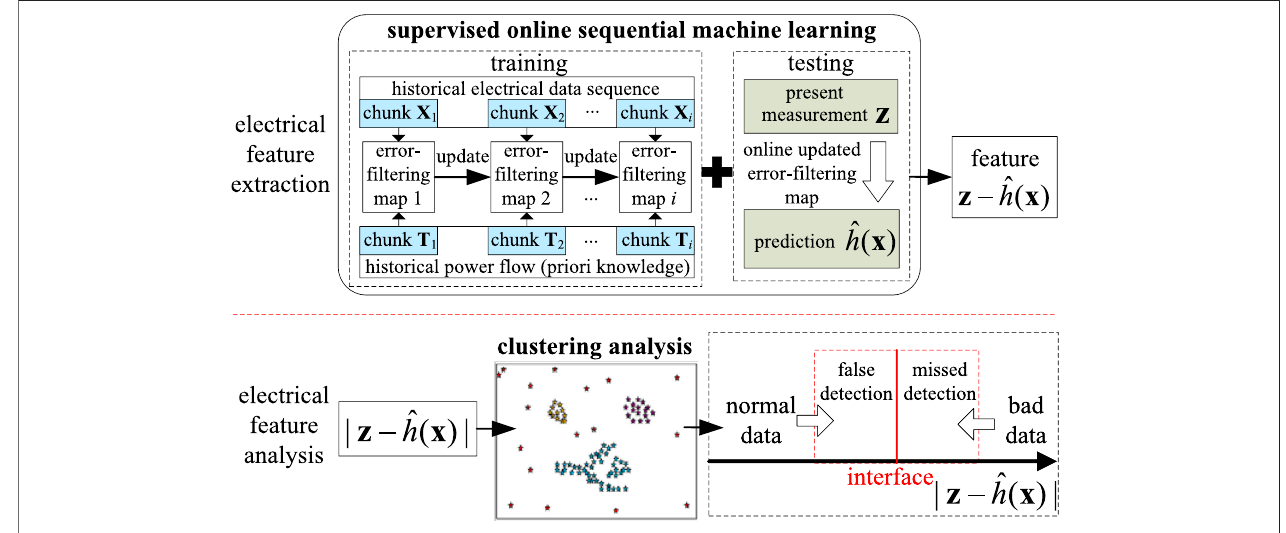
FIGURE 4 | Bad data detection based on online sequential machine learning.